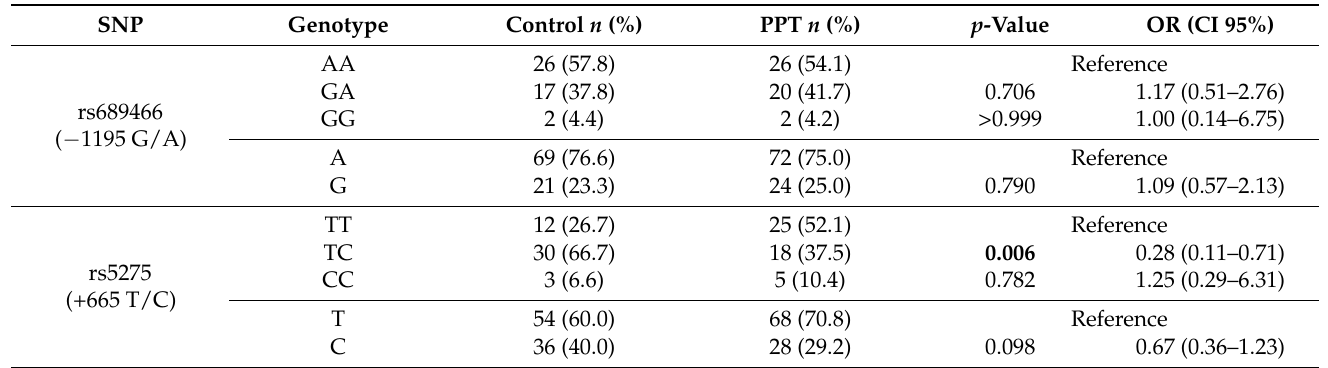
Table 3. Genotype and allele distribution according to PPT and controls.